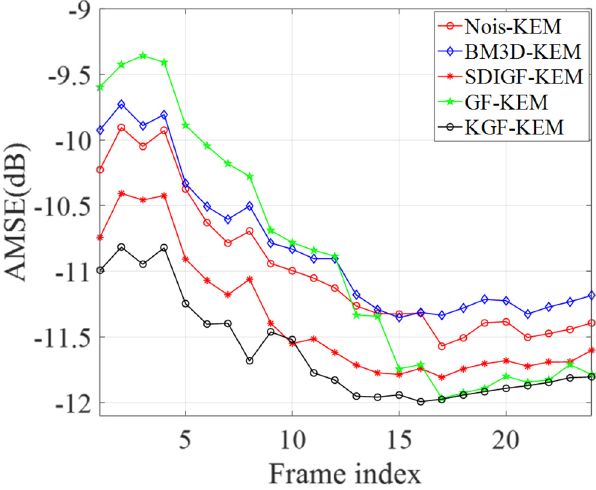
Fig 8. AMSEs of KEM reconstructed image frames from the sinograms denoised by different methods.